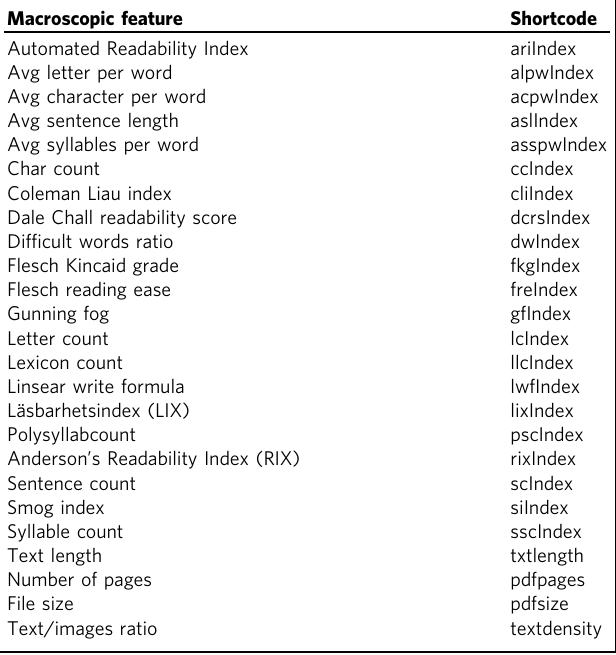
Table 2 List of computed macroscopic features (Crossley et al., 2011).